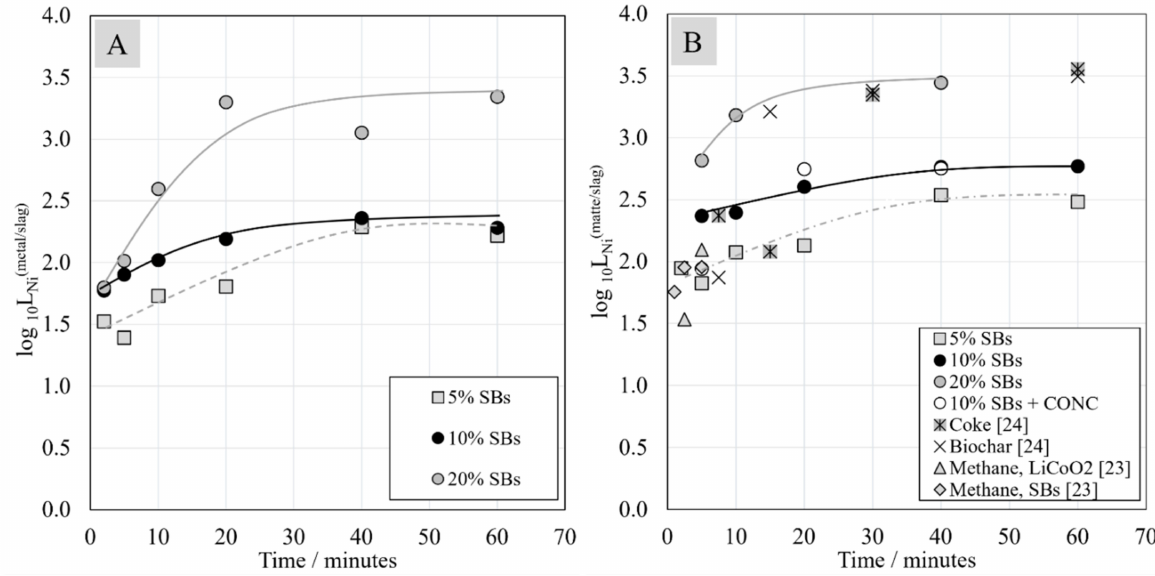
Figure 12. Distribution coefficients of nickel between metal alloy and the slag ( A ) and between matte and the slag ( B ) as a function of contact